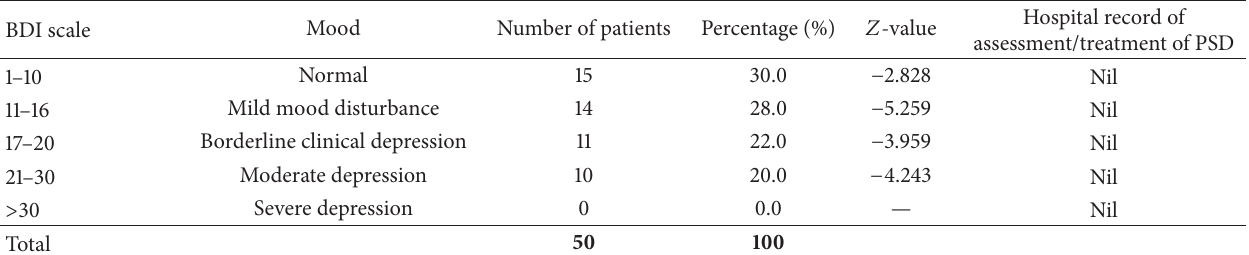
Table 1: Distribution of depression among stroke patients ( 𝑁 = 50 ).